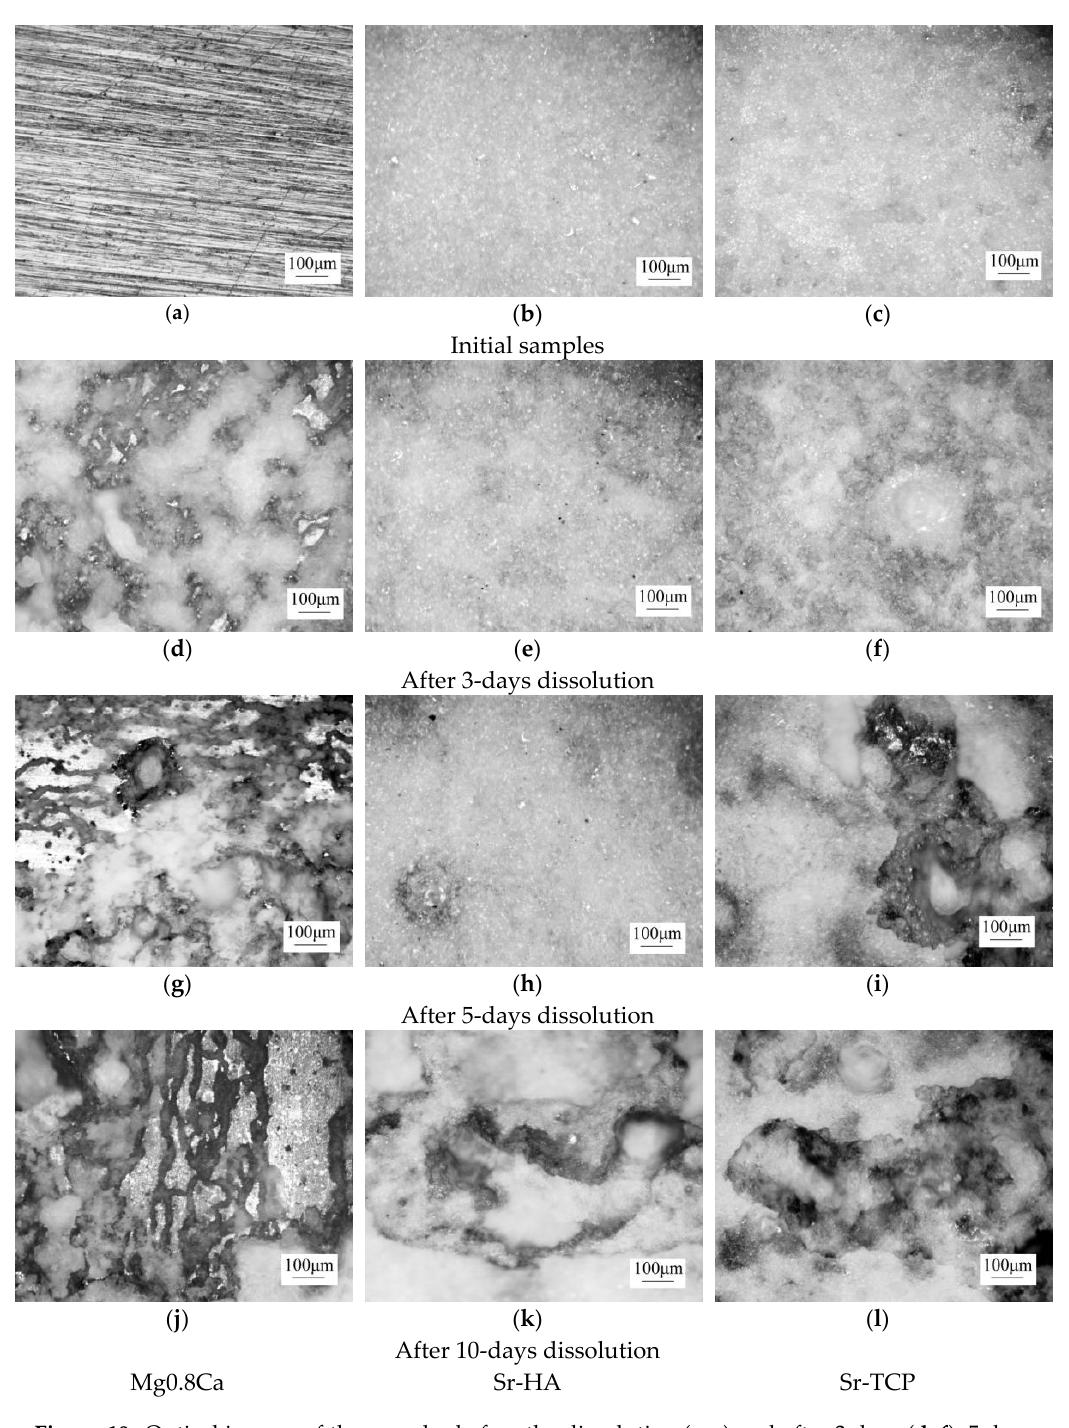
Figure 10. Optical images of the samples before the dissolution ( a – c ) and after 3 days ( d – f ), 5 days ( g – i ), and 10 days ( j – l ) of dissolution; ( a , d , g , i )—bare alloy Mg0.8Ca, ( b , e , h , k )—Sr-HA (500V) and ( c , f , i , l )—Sr-TCP(500V)